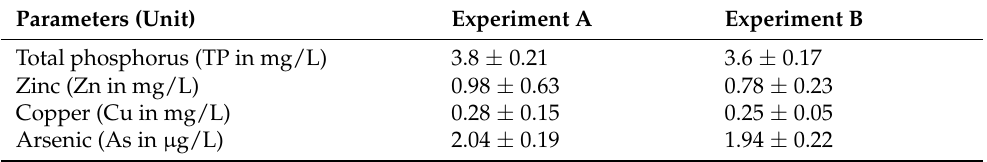
Table 1. Cont. Parameters